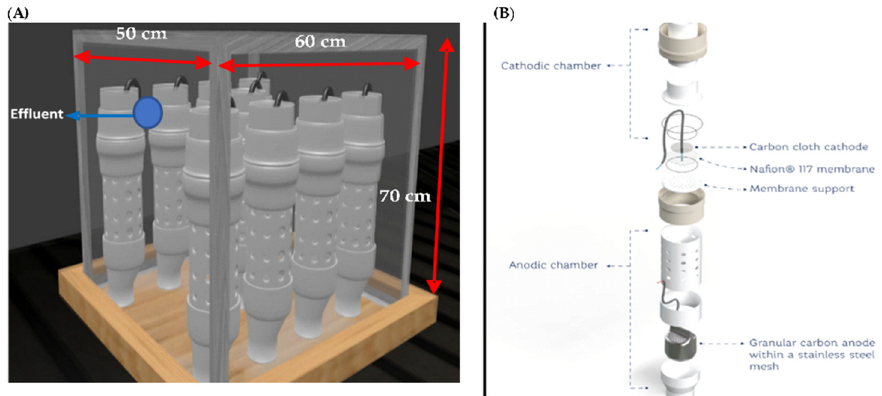
Figure 1. Stack Setup: ( A ) Assembly for 9 cells; ( B ) MFC components [16]. Reproduced with permission from Rodrigo Valladares Linares, Water ; published by MDPI, 2019.